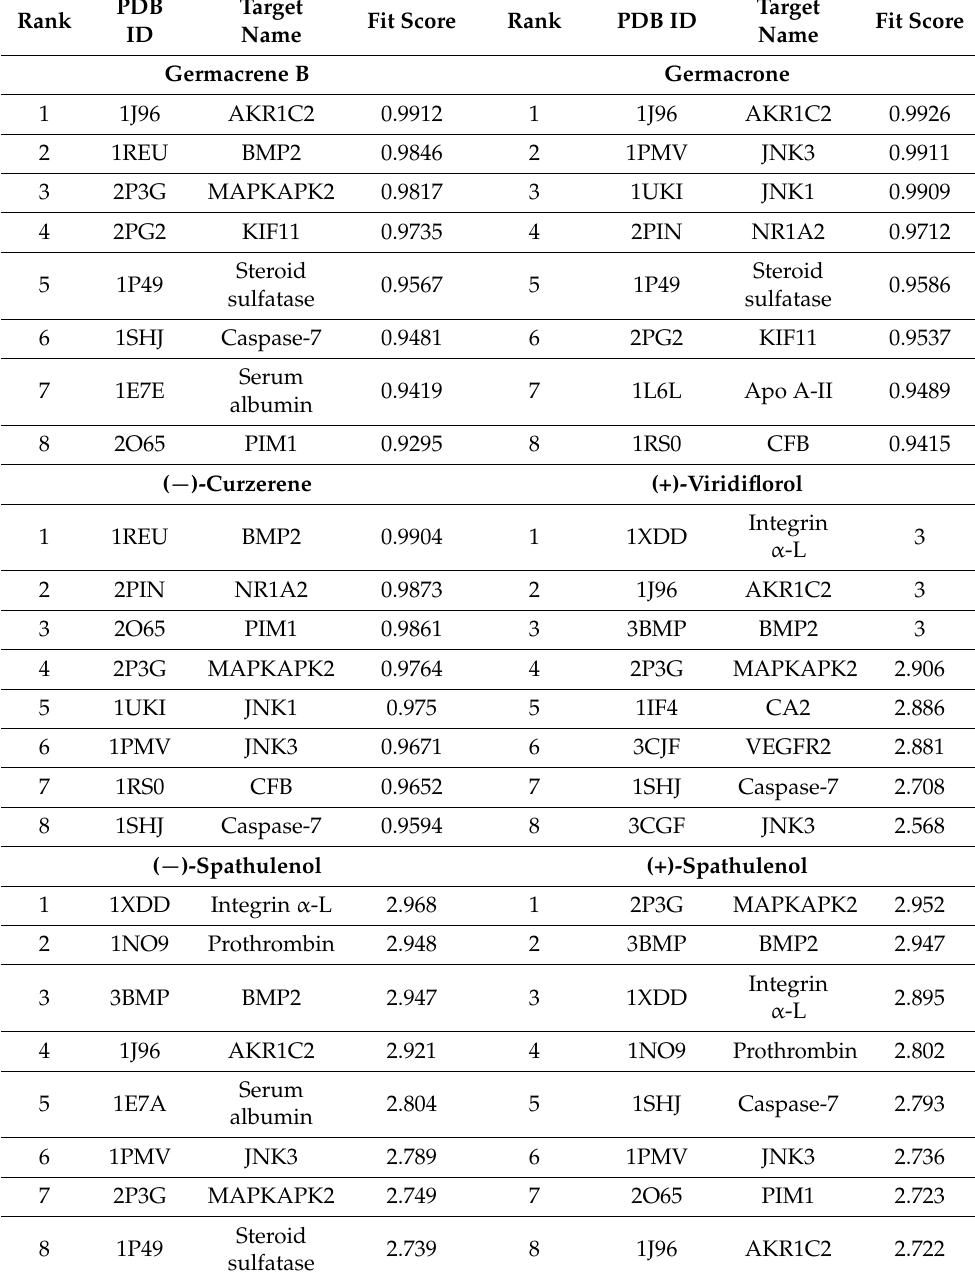
Table 6. Potential protein targets identified by PharmMapper for germacrene B,